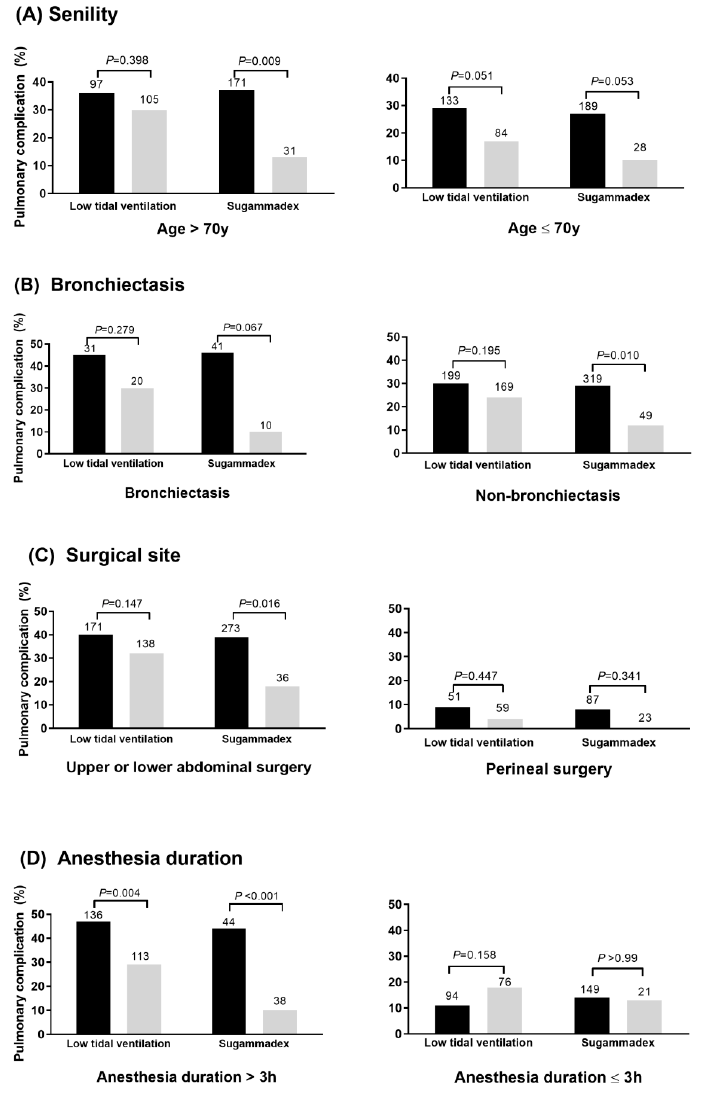
Figure 2. Respective impact of low tidal volume ventilation and sugammadex use in high- and low-risk subgroups stratified by ( A ) age, ( B ) bronchiectasis, ( C ) surgical site, and ( D ) anesthesia duration. The gray bar indicates the patients with low tidal volume ventilation or sugammadex use. The number above the bar indicates the total number of patients within the subgroup.